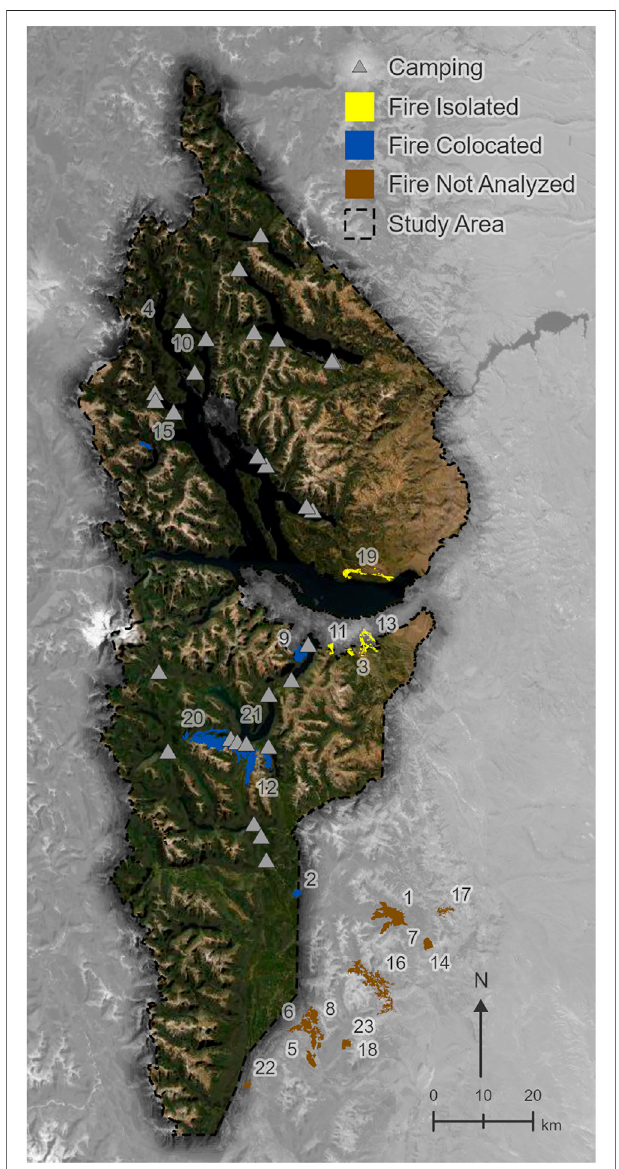
FIGURE 13 | Fires and campsites within the study